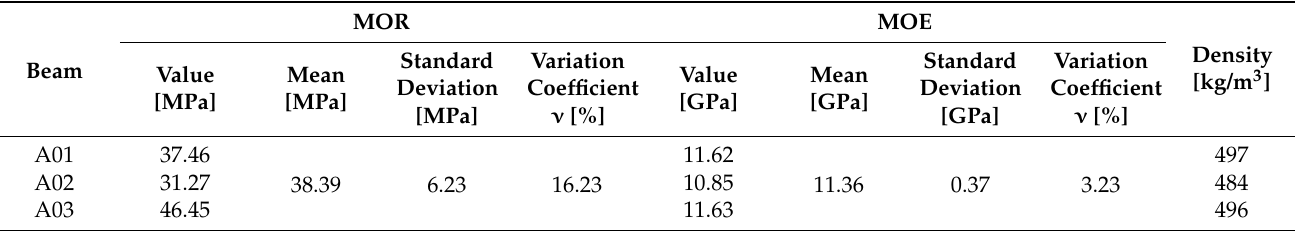
Table 6. The results of bending technical scale beams and values of their density.